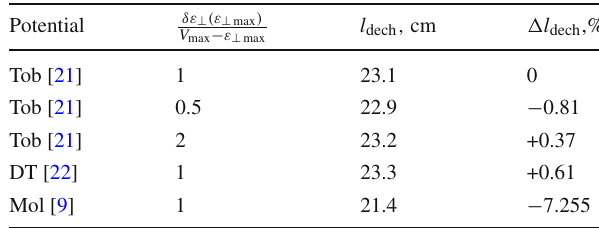
Table 1 Dechanneling length and precision of its evaluation